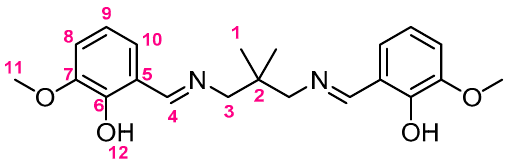
Figure 4. NMR numbering scheme for H 2 L.